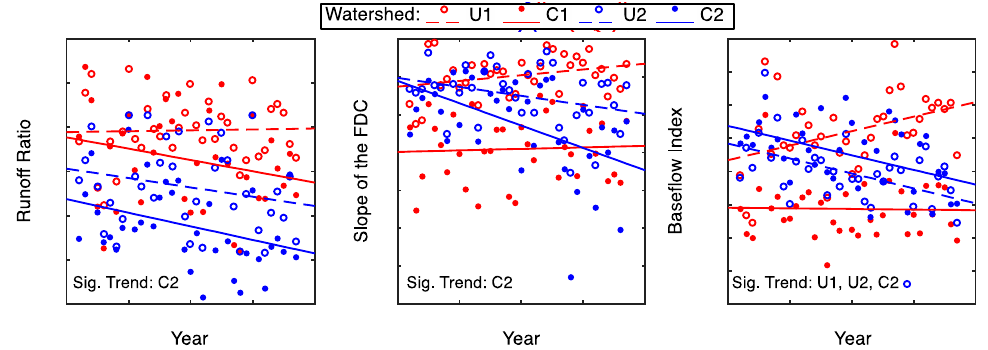
10 of 20 Table 5. Mean streamflow signature values for the before- and after-urbanization periods by watershed. Footnotes indicate the p value of trend analysis over the study period. Streamflow